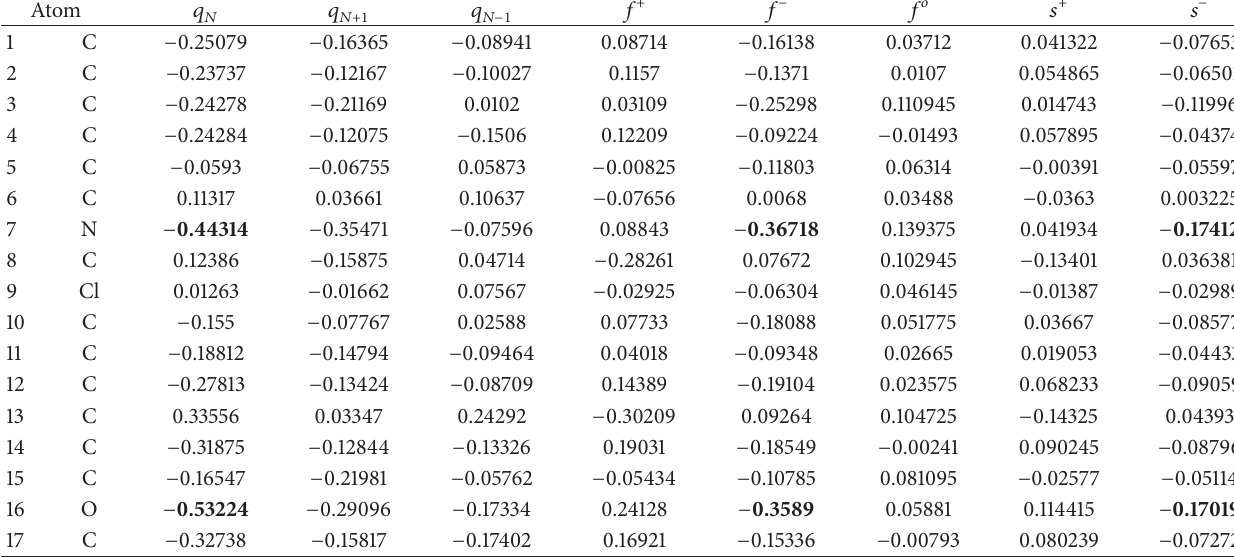
Table 5: Calculated natural charges, Fukui functions, and local softness indices for the schiff base (2-CNMBA).